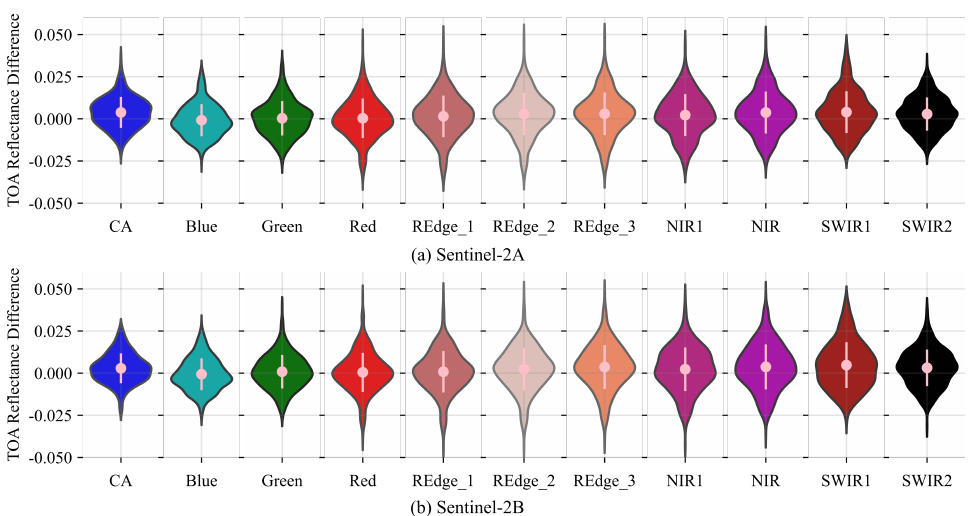
Figure 23. TOA reflectance difference between S2A’s observed information and the DAHAC model’s response across eleven spectral